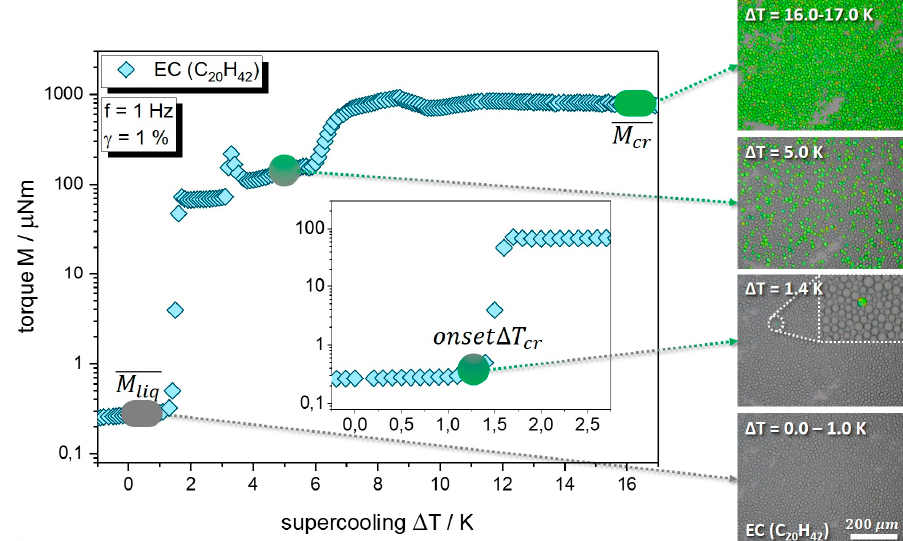
Figure 1. Torque M as a function of supercooling at constant deformation γ of 1% and frequency f of 1 Hz of 10 wt % eicosane dispersion. Micrographs on the right are depicted results of quiescent crystallization (without mechanical treatment).